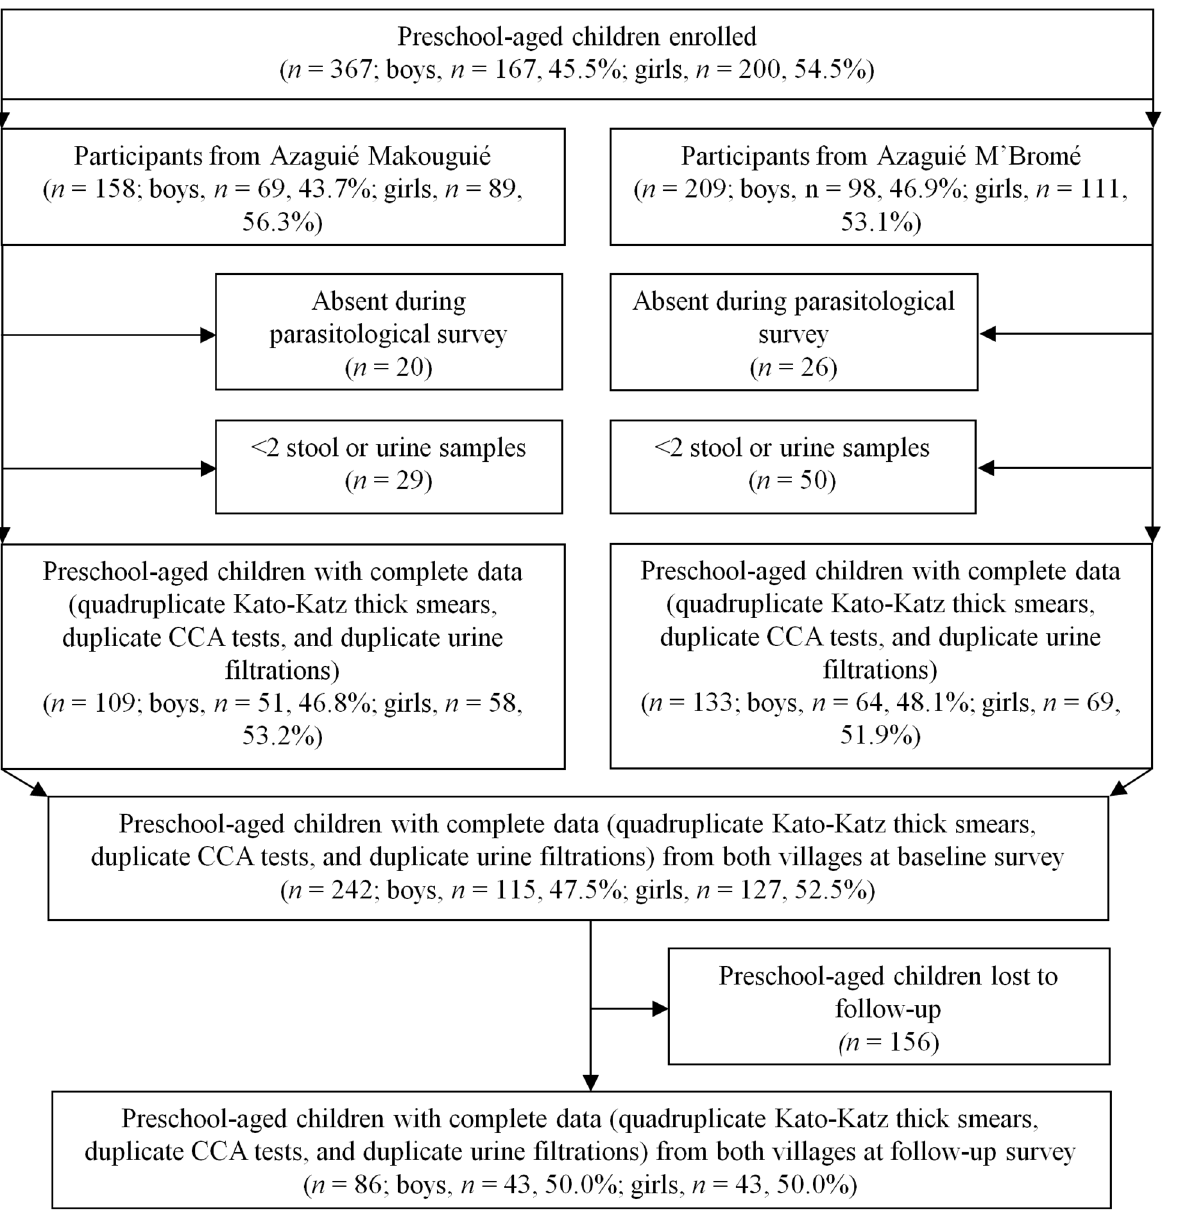
PLOS Neglected Tropical Diseases |